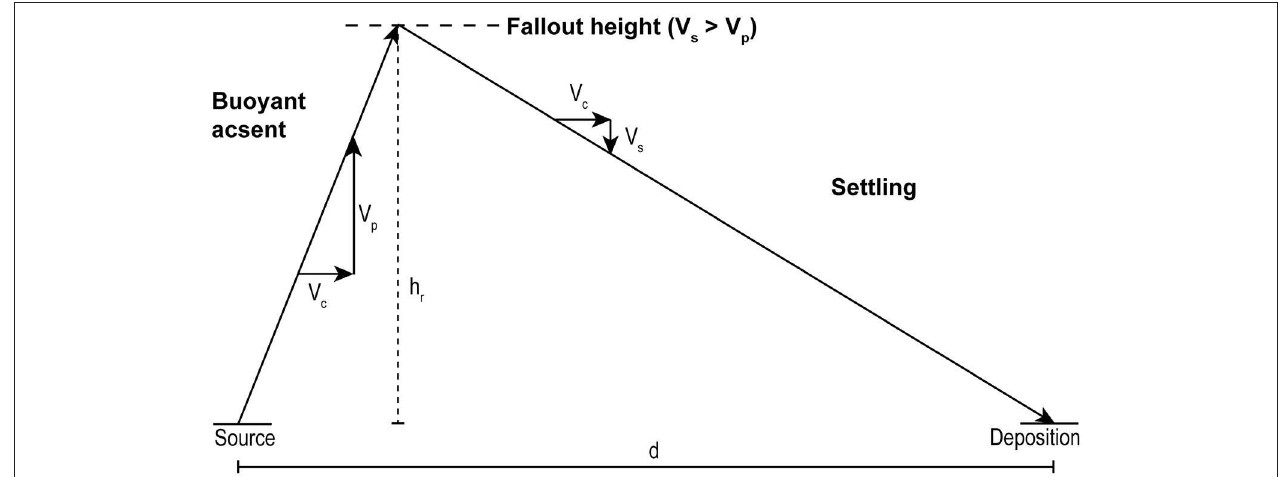
FIGURE 9 | A schematic view of the simplified dispersal process that we considered here and the variables that are calculated.